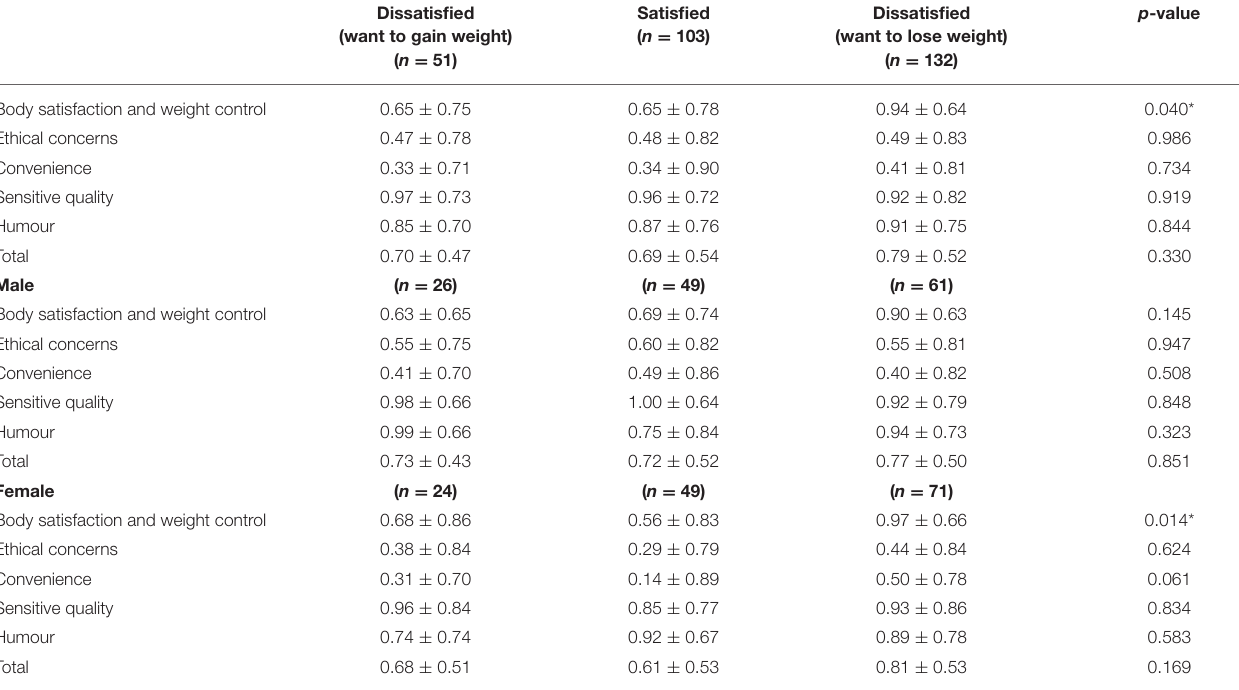
TABLE 2 | Mean values of the categories of the Food Choices Questionnaire according to the levels of the body (dis)satisfaction. Dissatisfied (want to gain